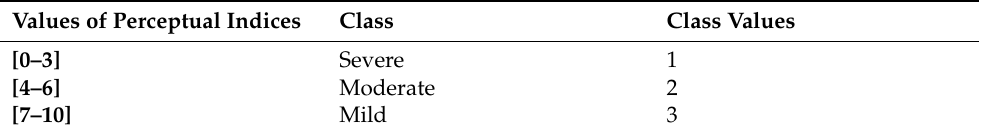
Table 2. Perceptual indices conversion for multiclass classification experiments. Values of Perceptual